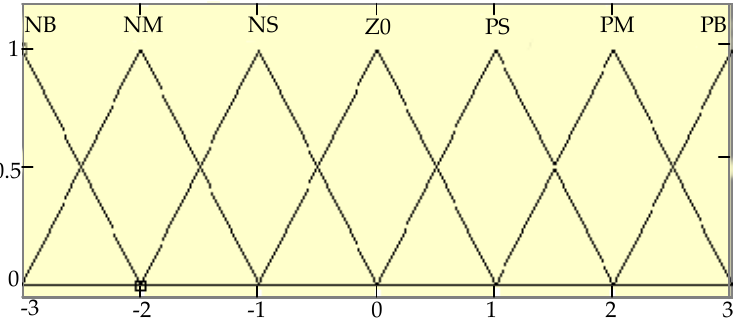
Figure 7. The distribution of the membership function of θ , E, and U.